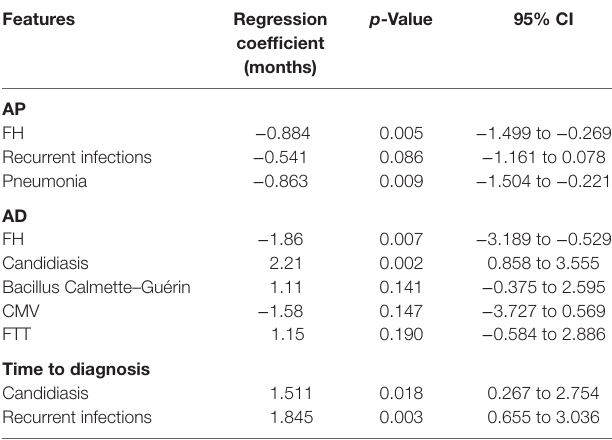
TaBle 6 | Multivariate linear regression of features that affect age at presentation (AP), age at diagnosis (AD), and time to diagnosis in patients fulfilled selection criteria ( n =